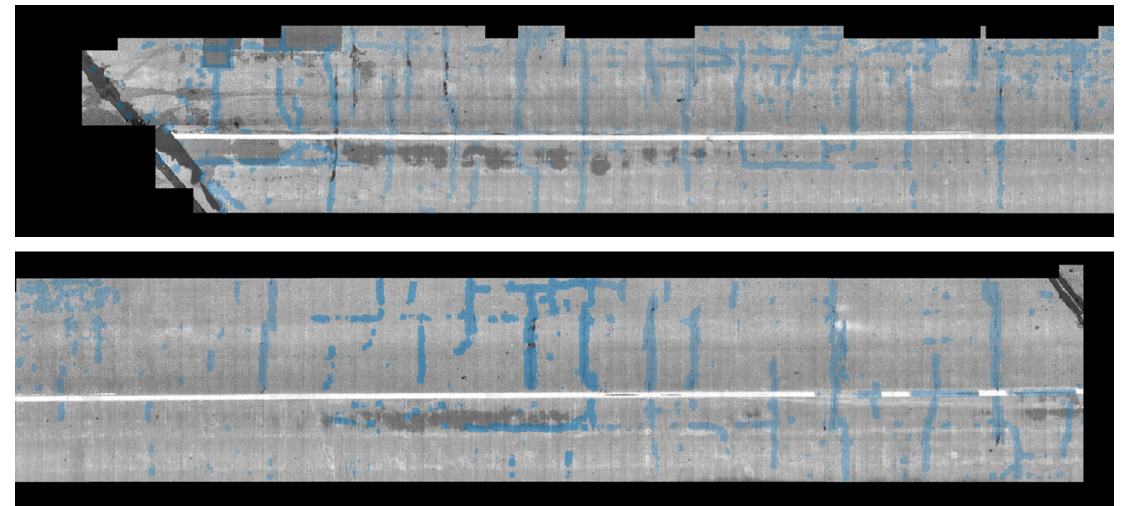
Figure 15. Cracks detected on the top surface of a bridge deck.